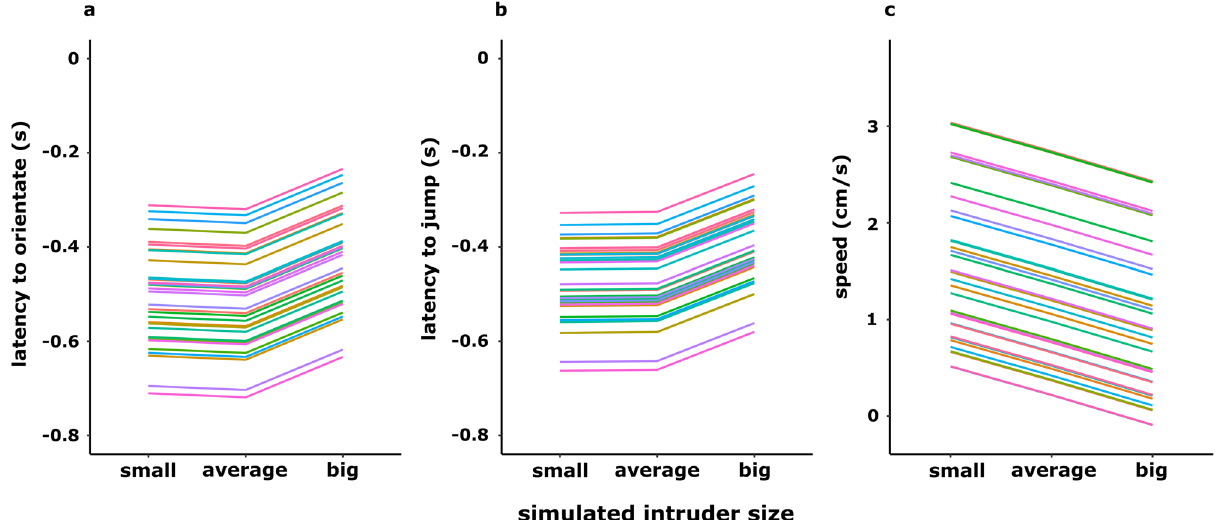
Figure 2. Predicted individuals’ latency to orientate ( a ), latency to jump ( b ) and speed to approach ( c ) a small, averaged sized, and big intruder. Each panel presents the prediction lines of the best fit model (random intercept model) which assumes that males do not differ based on their aggressiveness level in how they adjust their behavioral response across the three treatments. Each line represents a different individual. A constant transformation has been applied on the three response